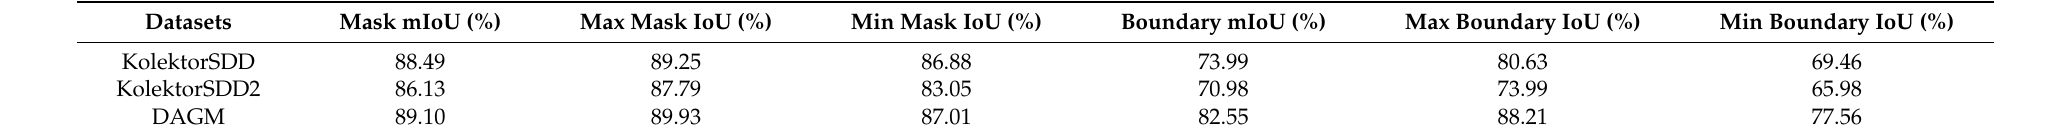
Figure 12. Examples of DAGM defect segmentation results. Table 1. Defect segmentation results of